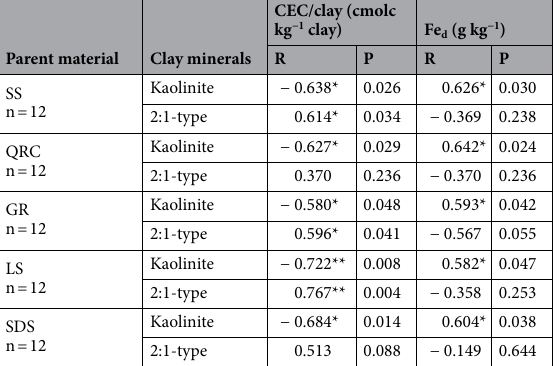
Table 3. Correlation coefficients between the clay minerals and CEC/clay and Fe d . *Significant at the 0.05 level. **Significant at the 0.01